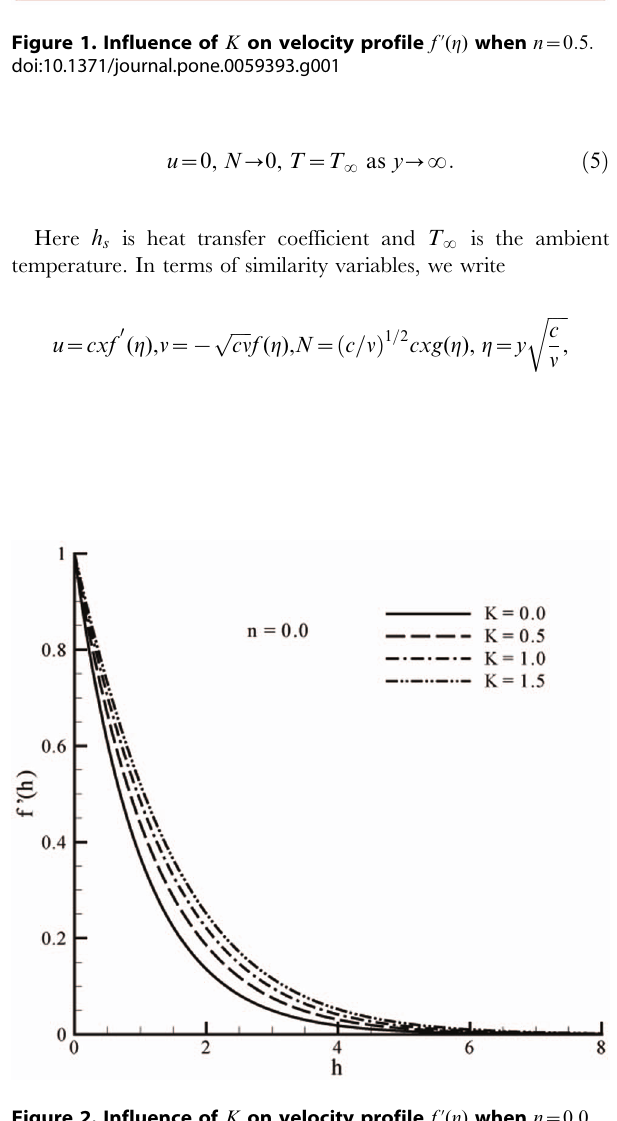
Figure 2. Influence of K on velocity profile f ’ ( g ) when n ~ 0 : 0 :